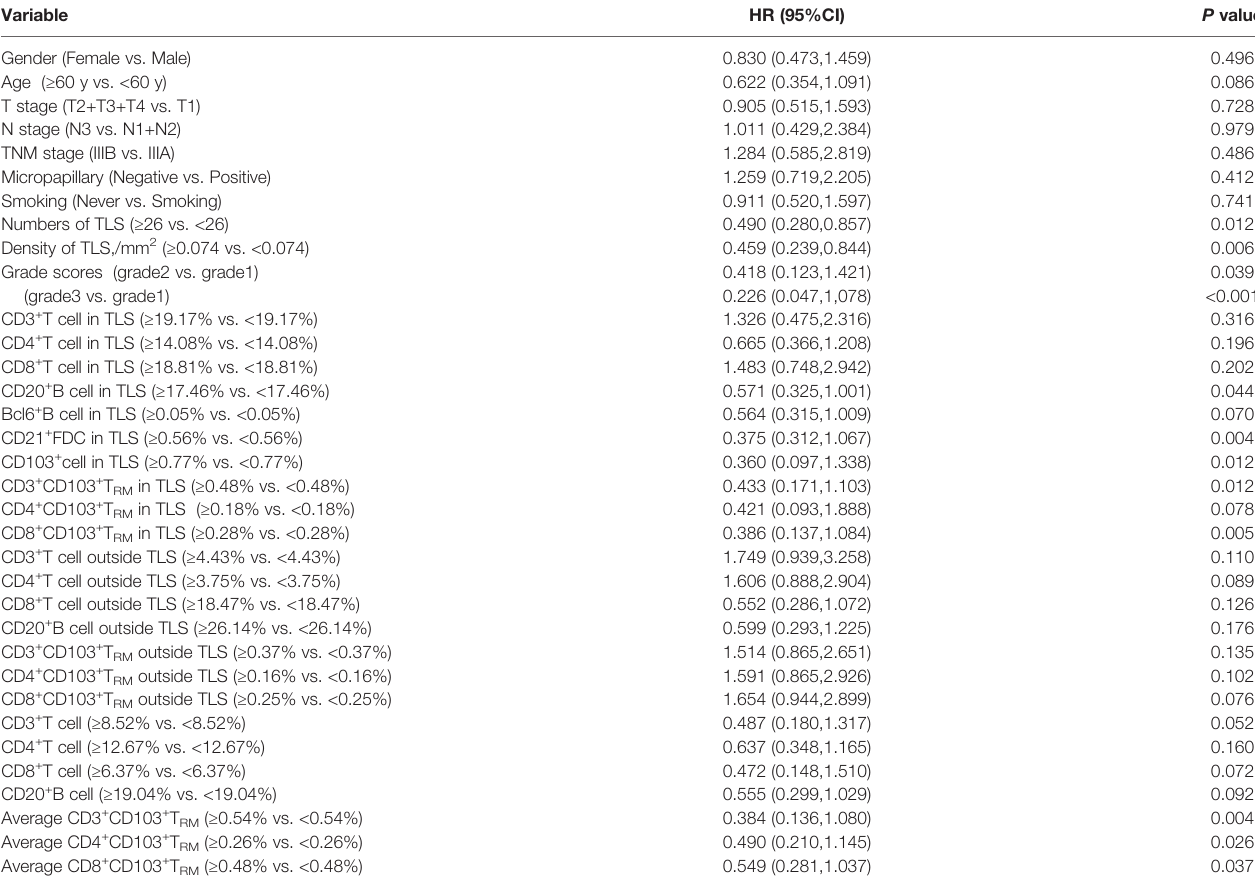
TABLE 4 | Univariate analysis of clinical and immune characteristics affecting DFS of patients in the study.